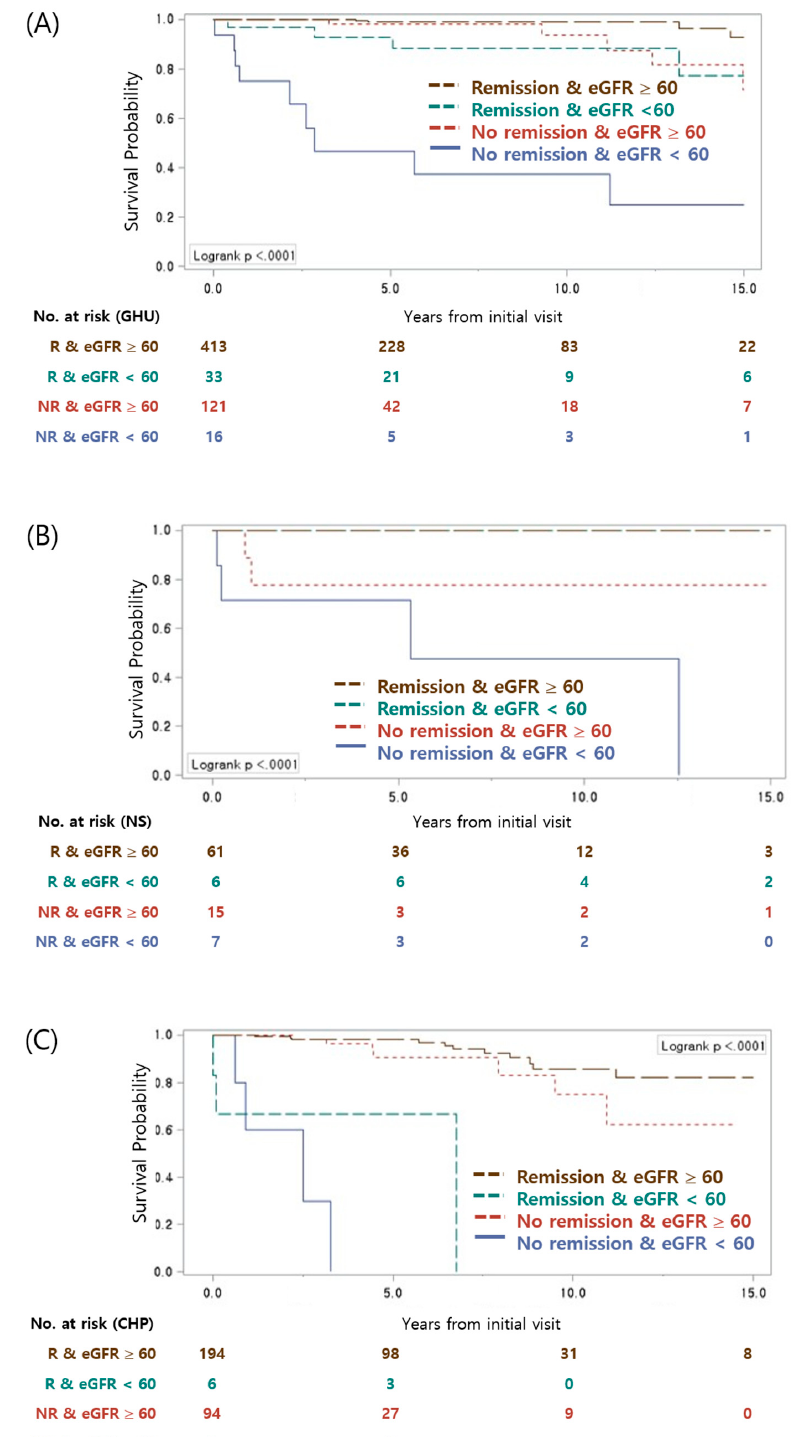
Figure 4. CKD–free survival rates among those who presented with ( A ) gross hematuria (GHU), ( B ) nephrotic syndrome (NS), or ( C ) combined hematuria and proteinuria (CHP) according to remission status or eGFR at renal biopsy. R: remission; NR: non-remission; eGFR: estimated glomerular filtration rate, mL/min/1.73 m 2 .